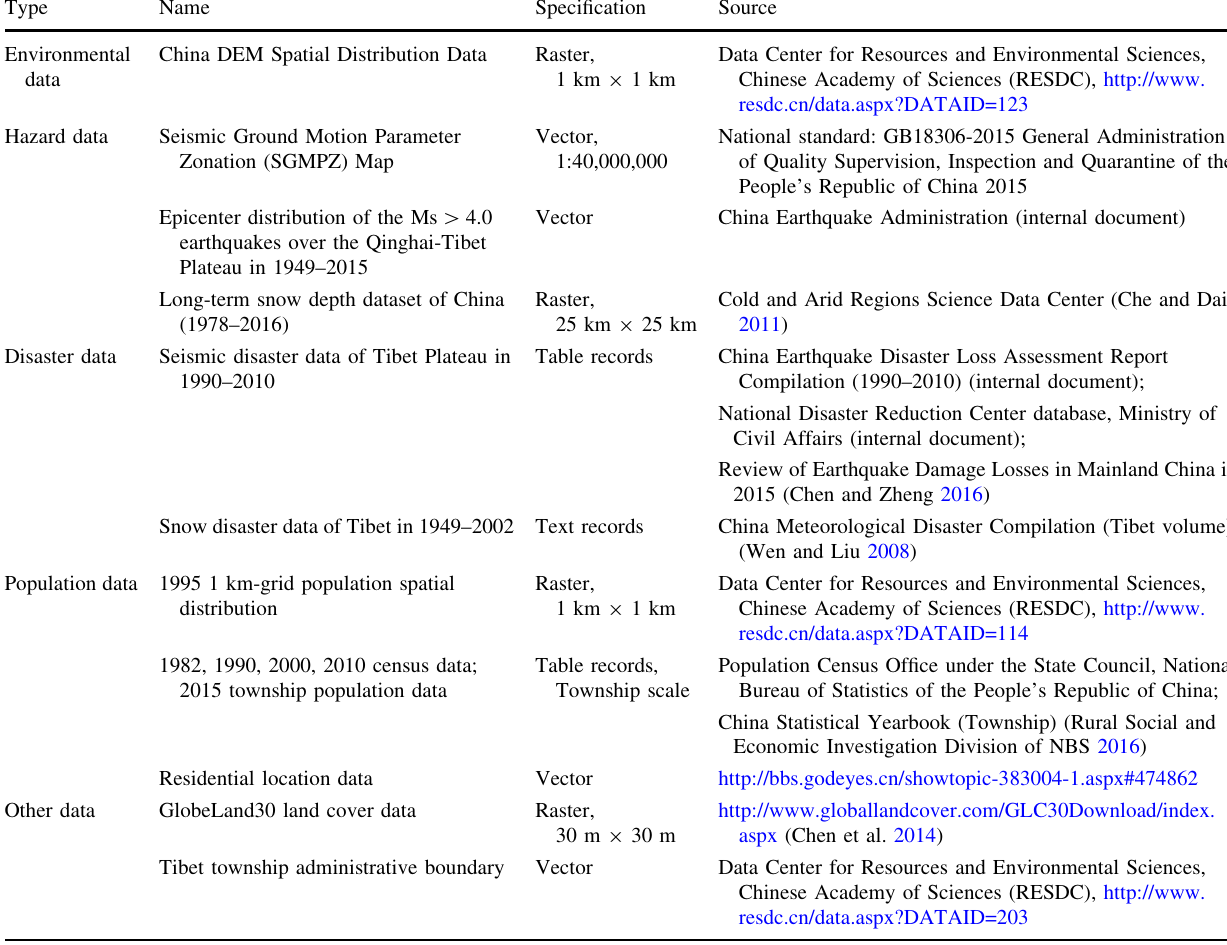
Table 1 Basic data for studying hazard exposure in Tibet, 1982–2015